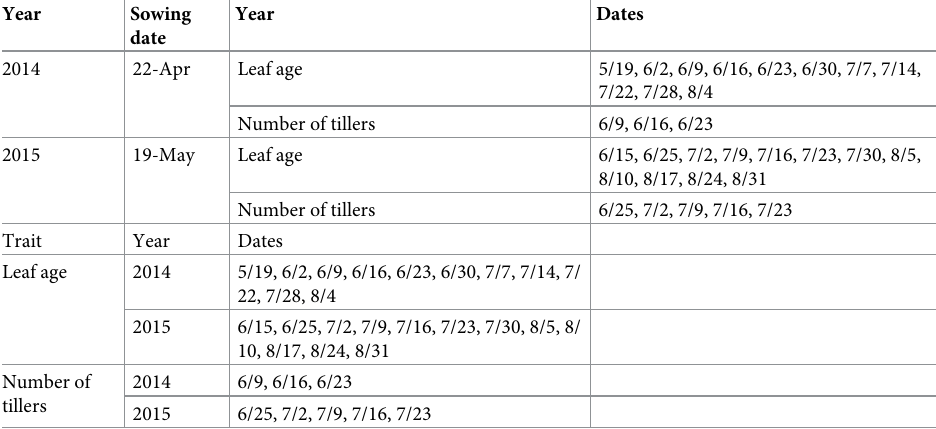
Table 1. Dates of observation of leaf age and number of